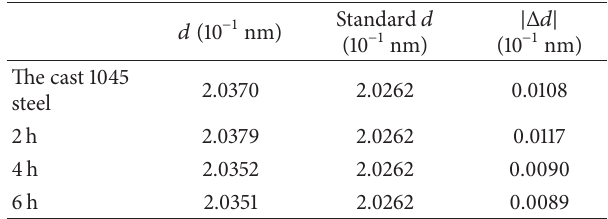
Figure 9: Tensile stress-strain curves (a), tensile and yield strength (b), and elongation rate (c) of the 1045 steel without and with annealing at 873 K (600 ∘ C) for different time. Table 4: The 𝑑 values (distance of crystal face) of the (110) peak of the steels without and with annealing at different time, the standard 𝑑 value of (110) peak, and the difference between